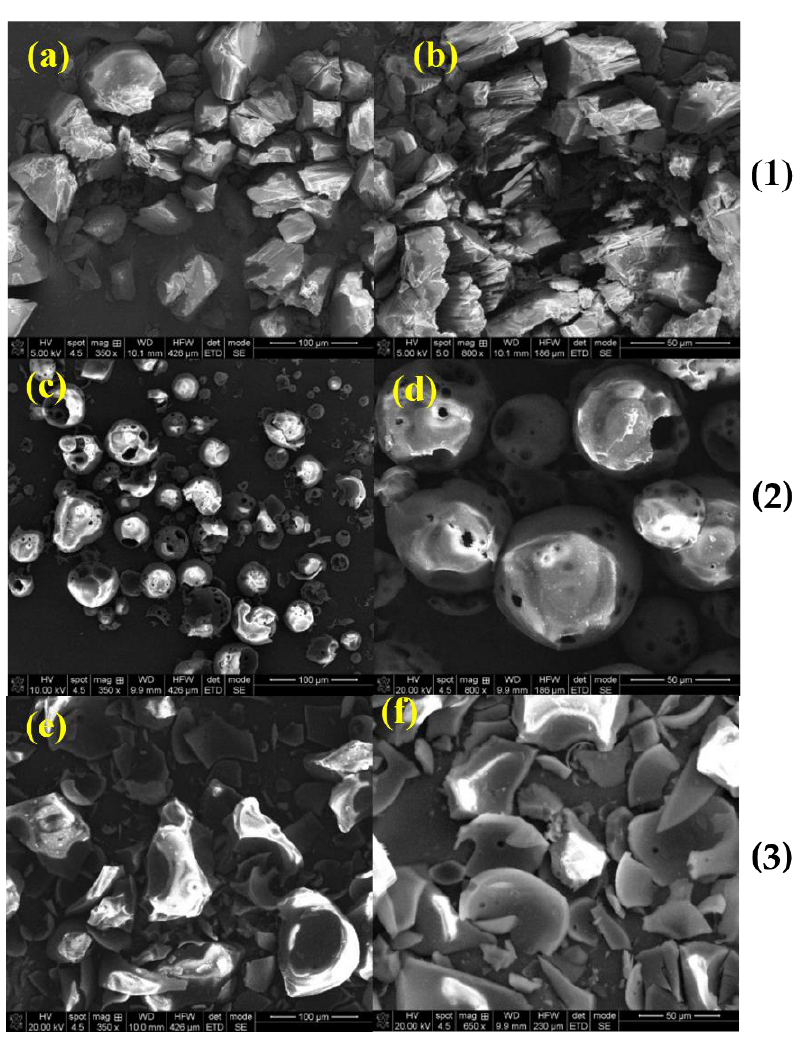
Figure 5. SEM images, at different magnifications, of ( 1 ) Nim; ( 2 ) HP- β -CD; and ( 3 ) Me- β -CD; ( a ) 350 ×; ( b ) 800 ×; ( c ) 350 ×; ( d) 800 ×; ( e ) 350 ×; ( f ) 650 ×.